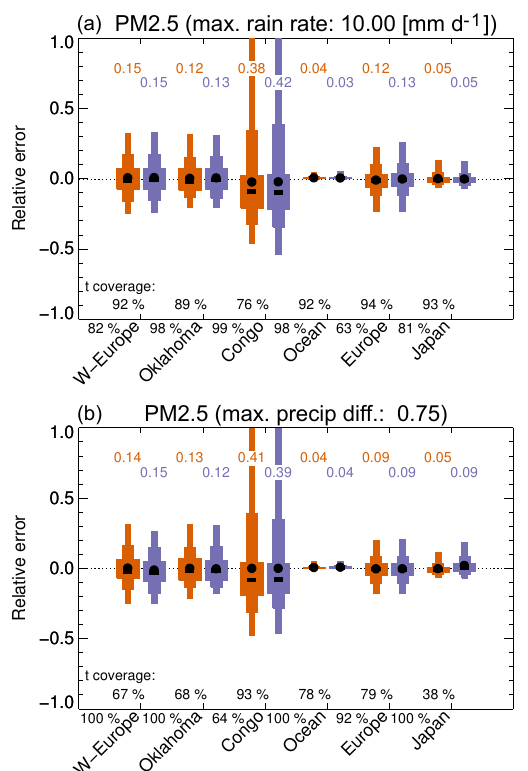
Figure 25. Impact on monthly representation errors from filtering out precipitation events. Orange box whiskers show errors when all data is used, purple box whiskers show errors when precipitation events are discarded ( a : daily precipitation > 10mmd − 1 ; b : daily precipitation difference > 0.75). Only locations where this maxi- mum was exceeded at least once were used in the statistics. Results for a 210 × 210km 2 grid box. Further explanation in Sect.